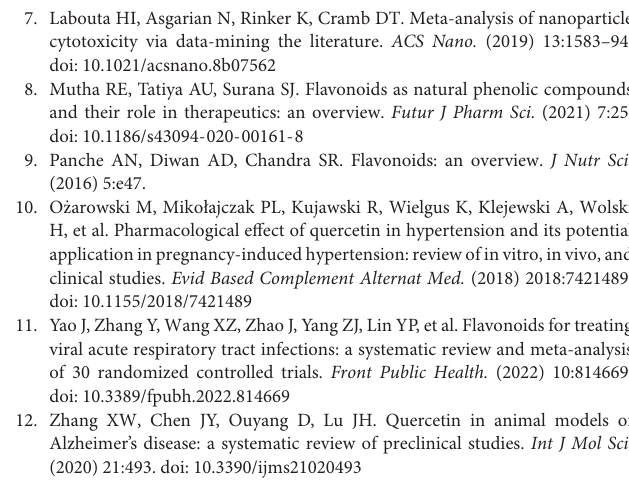
Supplementary Figure 1 | The structure of each